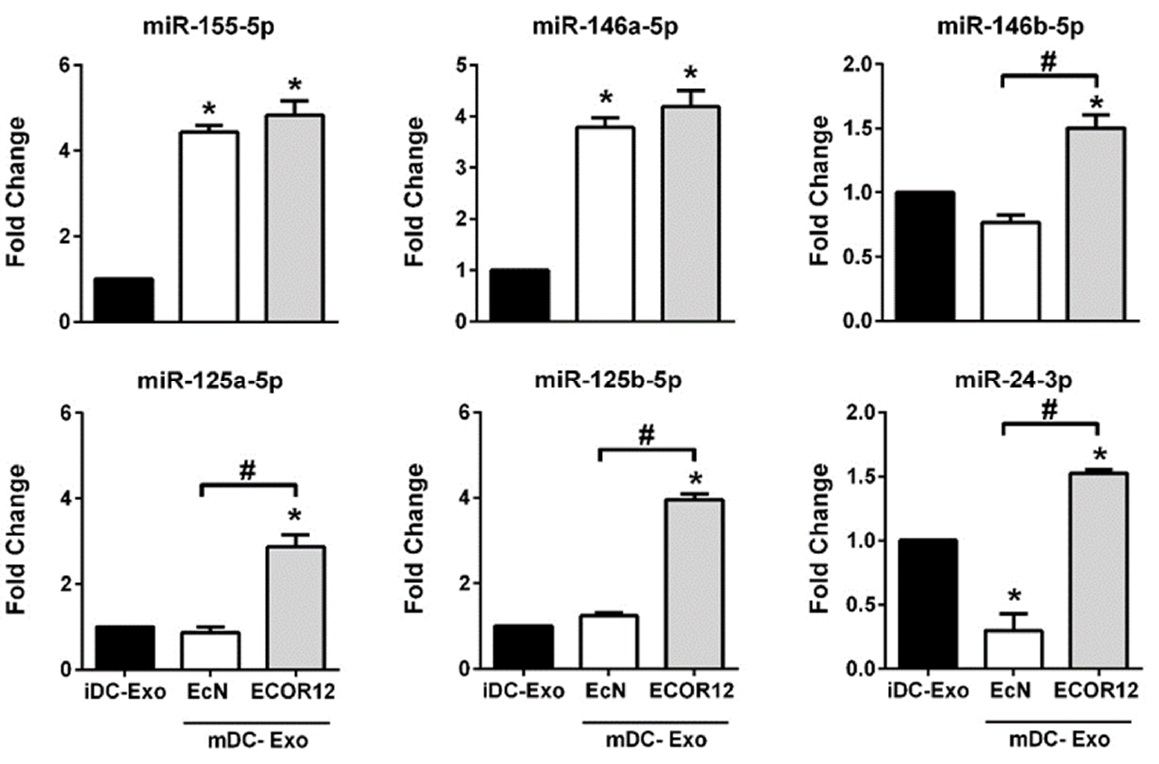
Figure 6. RT-qPCR expression analysis of selected miRNAs in exosomes isolated from DCs chal- lenged with BEVs of the indicated E. coli strains. Immature DCs were stimulated for 16 h with BEVs (10 μg/mL) from EcN (white bars) or ECOR12 (grey bars). Cells were washed twice and further incubated for 72 h in fresh medium before isolation of exosomes by ultracentrifugation. Untreated imma- ture DCs were processed in parallel (black bars). Relative miRNA levels of selected miRNAs known to be modulated by BEVs from EcN and ECOR12 in DCs were measured by RT-qPCR and normalized to the U6 reference gene. Data (mean ± SEM) are from three independent biological experiments (six donors) performed in triplicate and are presented as fold-change compared to untreated control cells. Statistical differences were assessed by one-way ANOVA, followed by Tukey’s test ( p < 0.05). * Significance against untreated control cells; # significance between cells stimulated with EcN MVs or ECOR12 BEVs.